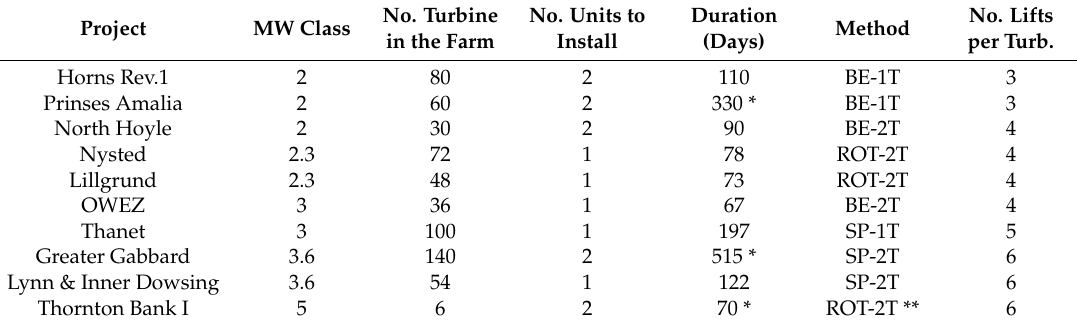
Table 2. North Sea installation characteristics, adapted from [28–30].